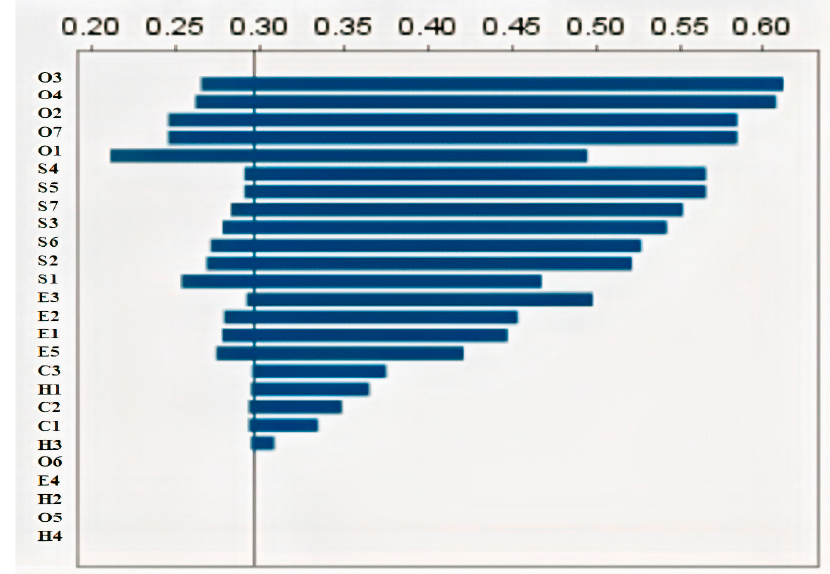
Figure 8. Tornado graph for sensitivity analysis of the risk of start-up Y—Risk2 .